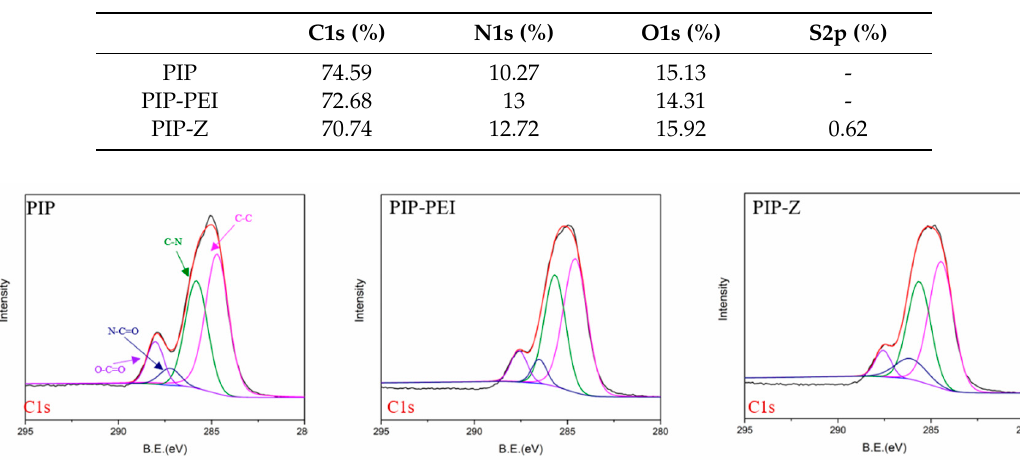
Figure 2. ATR-FTIR images of the membrane during each step of surface modification. Table 2. Bond analysis of the TFC membranes.